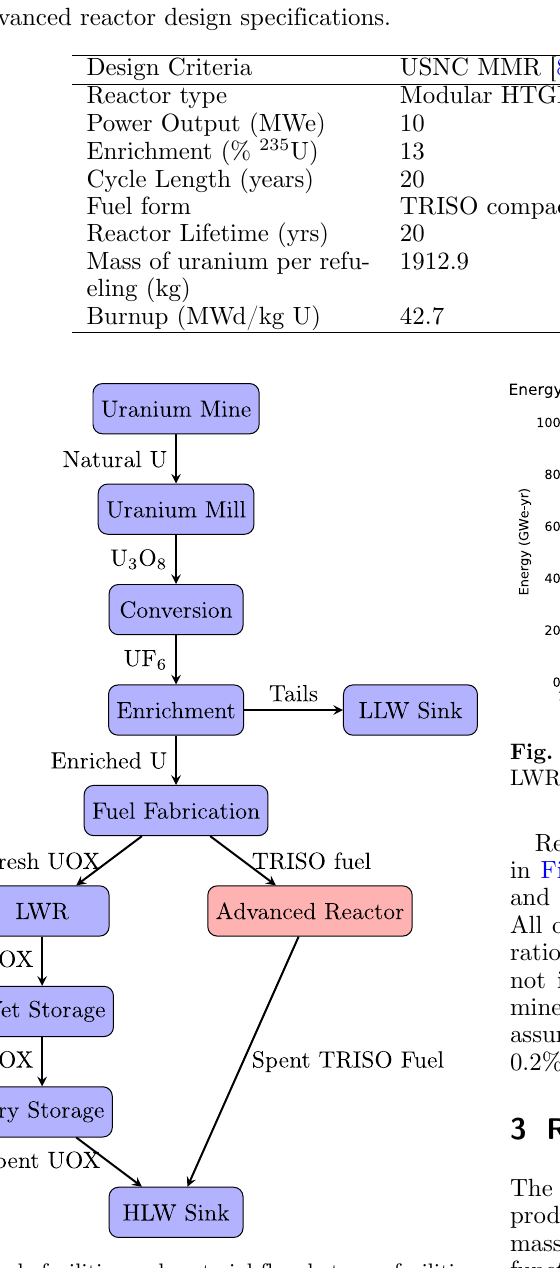
Fig. 1. Fuel cycle facilities and material flow between facilities. Facilities in red are deployed in the transition scenarios.